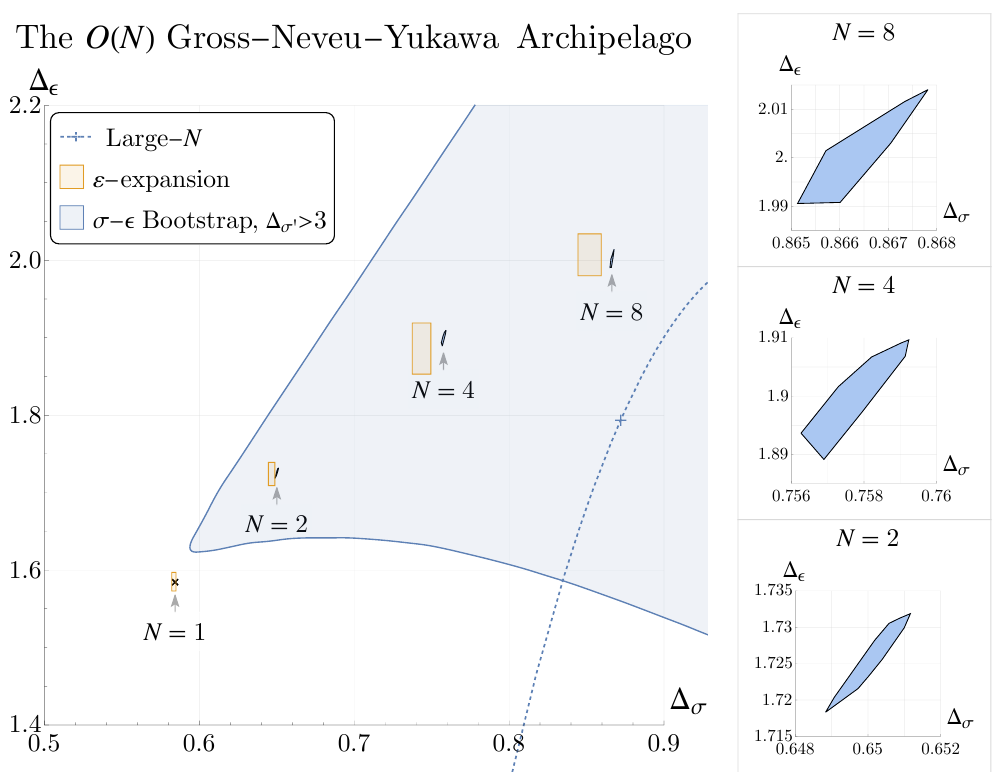
Figure 2 . A compilation of our N = 2 , 4 , 8 islands at n max = 18 , projected onto the (∆ σ , ∆ (cid:15) ) plane, compared against the perturbative estimates in the large- N expansion (represented by the dotted blue curve), Borel-resummations of the (4 − (cid:15) ) -expansion [31] (represented by the orange boxes), and the location of the N = 1 island from the N = 1 supersymmetric Ising bootstrap [42–44] (represented by the x). We also superpose the general σ - (cid:15) bootstrap bounds with the assumption ∆ 3 from σ 0 >